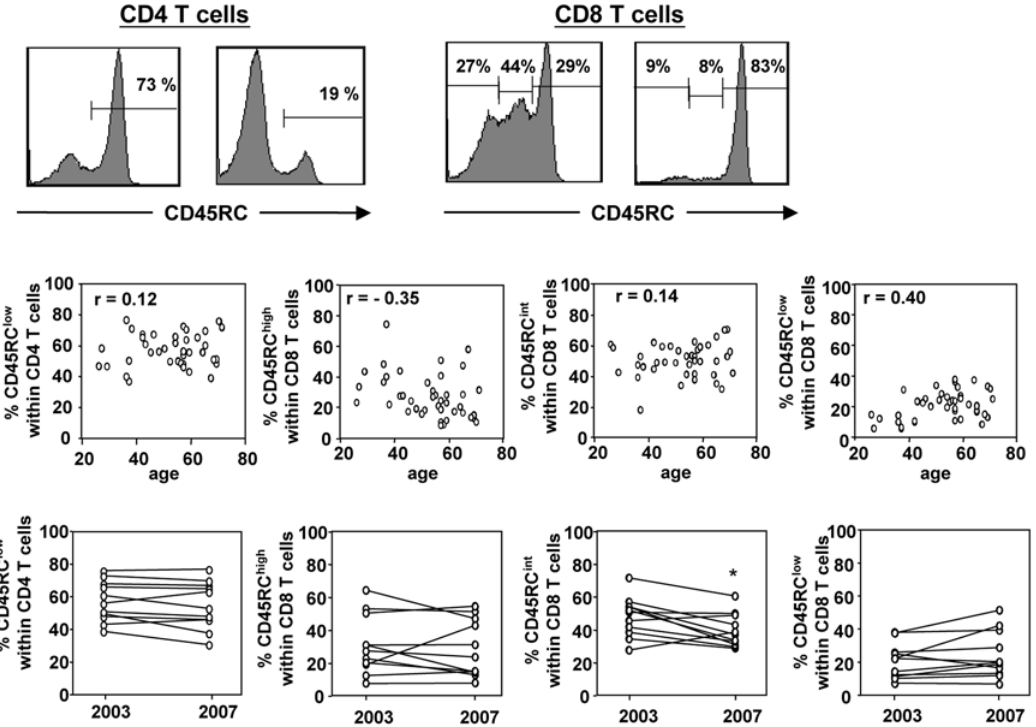
Figure 1. CD4 and CD8 CD45RC T cell subsets distribution in healthy individuals. Peripheral blood leukocytes from 39 healthy individuals (median age 55, range 25–70) were stained with mAbs against CD3, CD4, CD8, CD45RC. ( A ) The histograms represent the CD45RC expression on CD4 T cells (left panel) and CD8 T cells (right panel) from two healthy individuals showing the inter-individual variability in CD45RC expression. ( B ) The proportion of CD45RC low CD4 T cells (left panel) and the proportion of CD45RC high -CD45RC int -CD45RC low CD8 T cells (right panels) are presented according to age of the donors. Each dot represents a separate individual. The r- and p-values were calculated using linear regression. ( C ) Represent the percentage of CD45RC low CD4 T cells (left panel) or the proportion of CD8 CD45RC T cell subsets (right panel) of 11 individuals at 4 years interval. The p-values were calculated using the Wilcoxon matched-pairs test; *, p , 0.05.